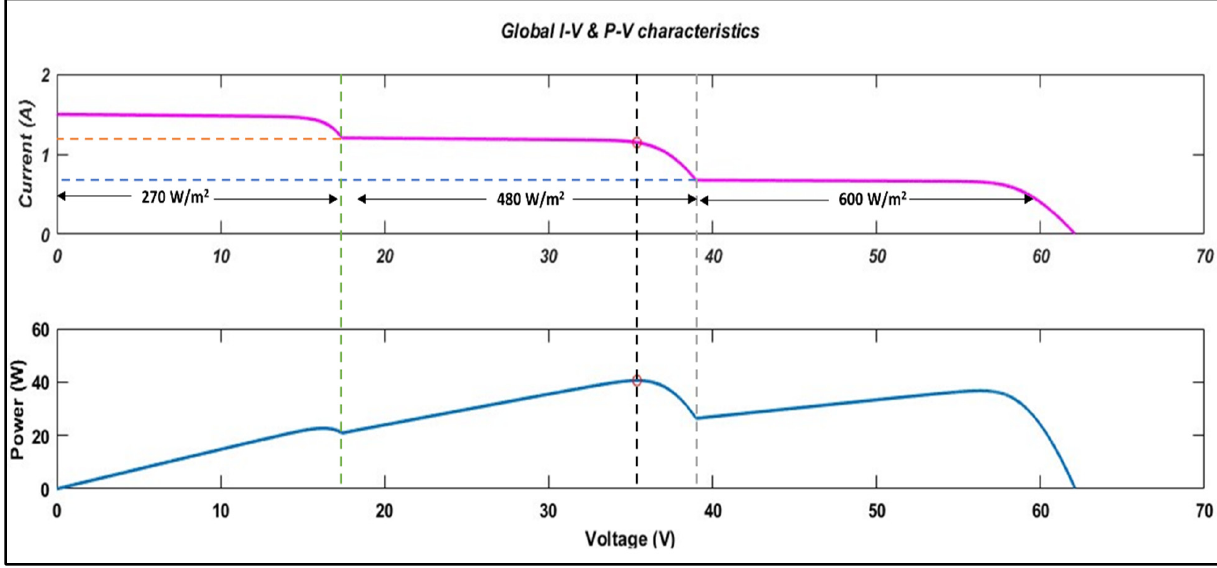
Figure 11. P–V and I–V characteristics of solar panel with PS.